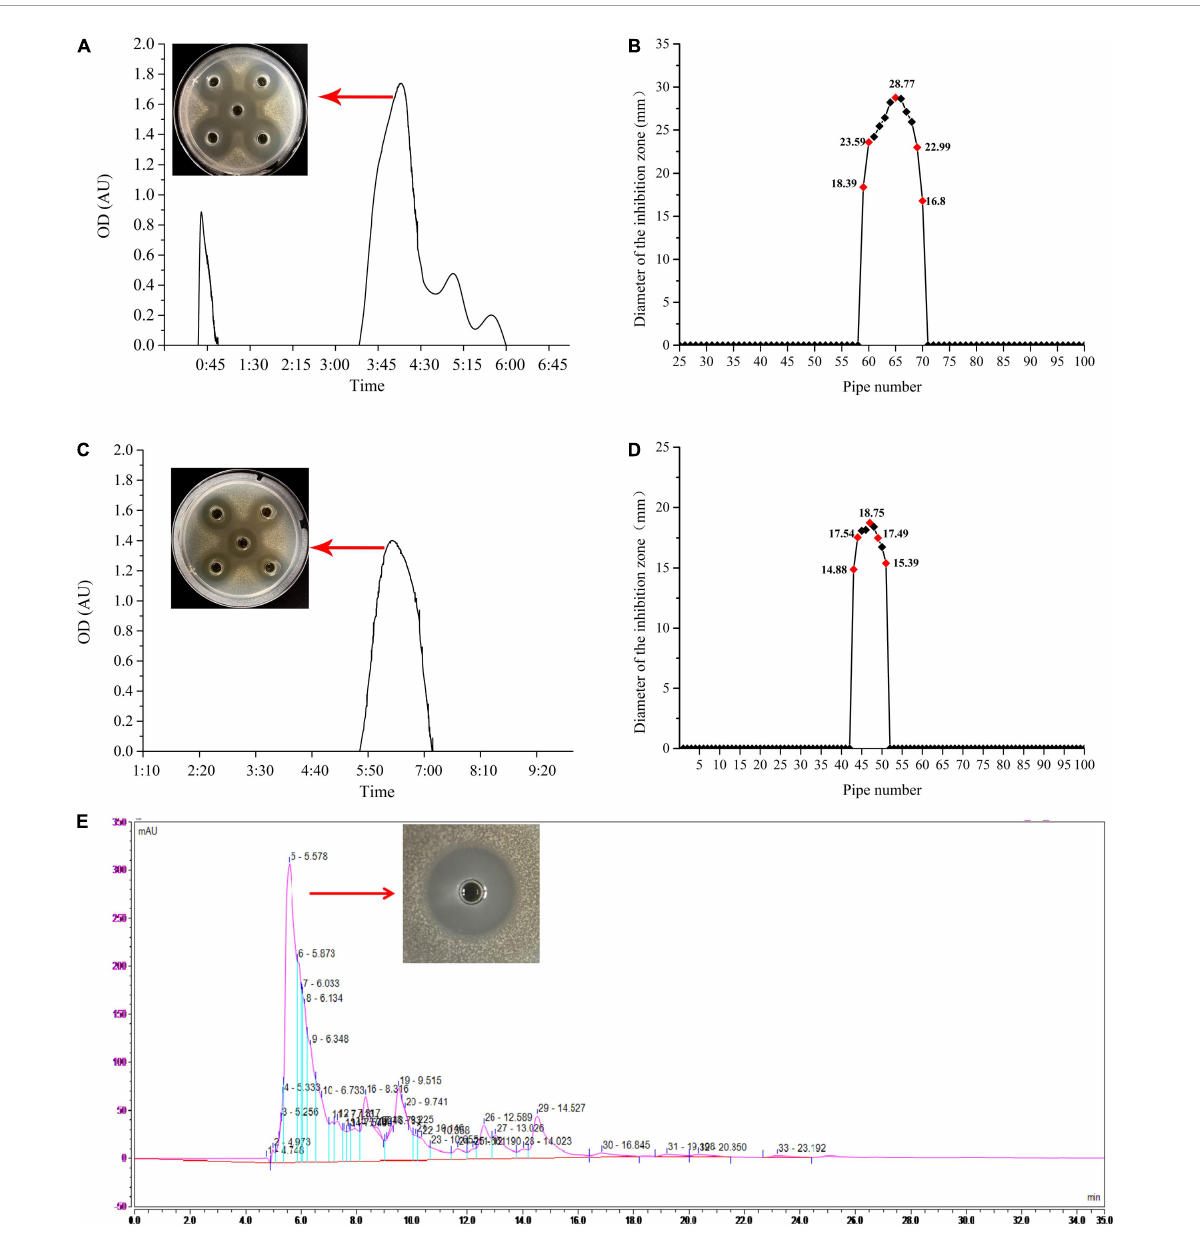
FIGURE3 The process of purification of the bacteriocin produced by strain W3-2. (A) Sephadex G-25 gel profile. (B) Sephadex G-25 elution curve. (C) Sephadex LH-20 gel profile. (D) Sephadex LH-20 elution curve. (E) Reversed-phase high-performance liquid chromatography (RP-HPLC) purification